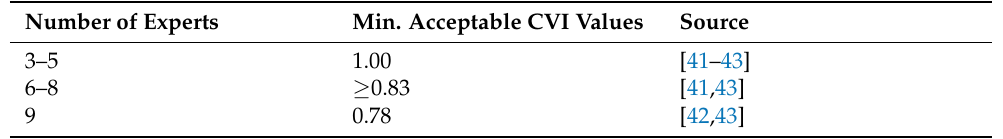
Table 2. The number of experts and acceptable cut-off CVI